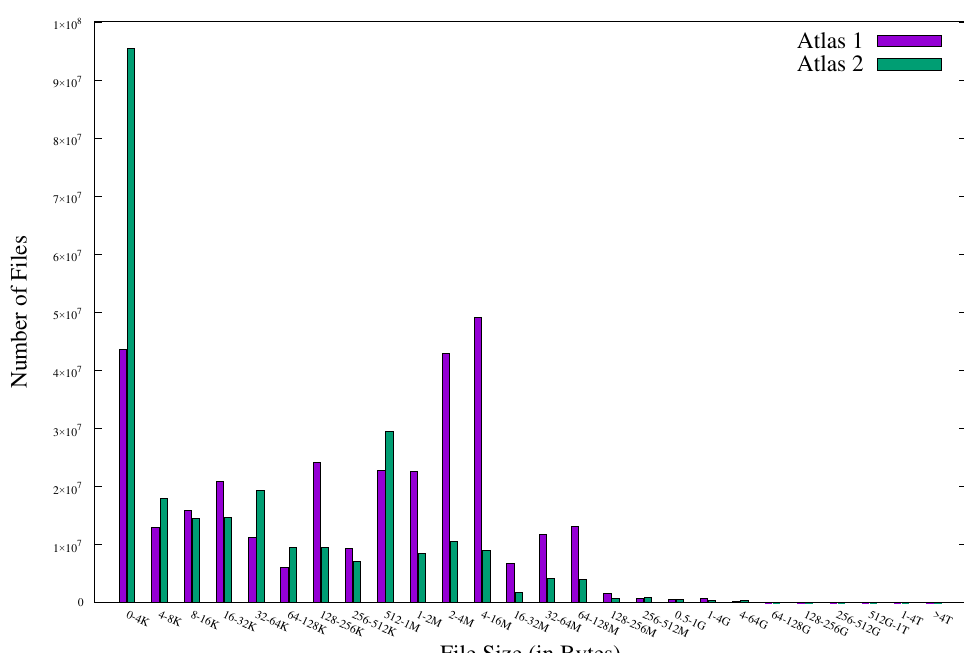
Figure 7. File size